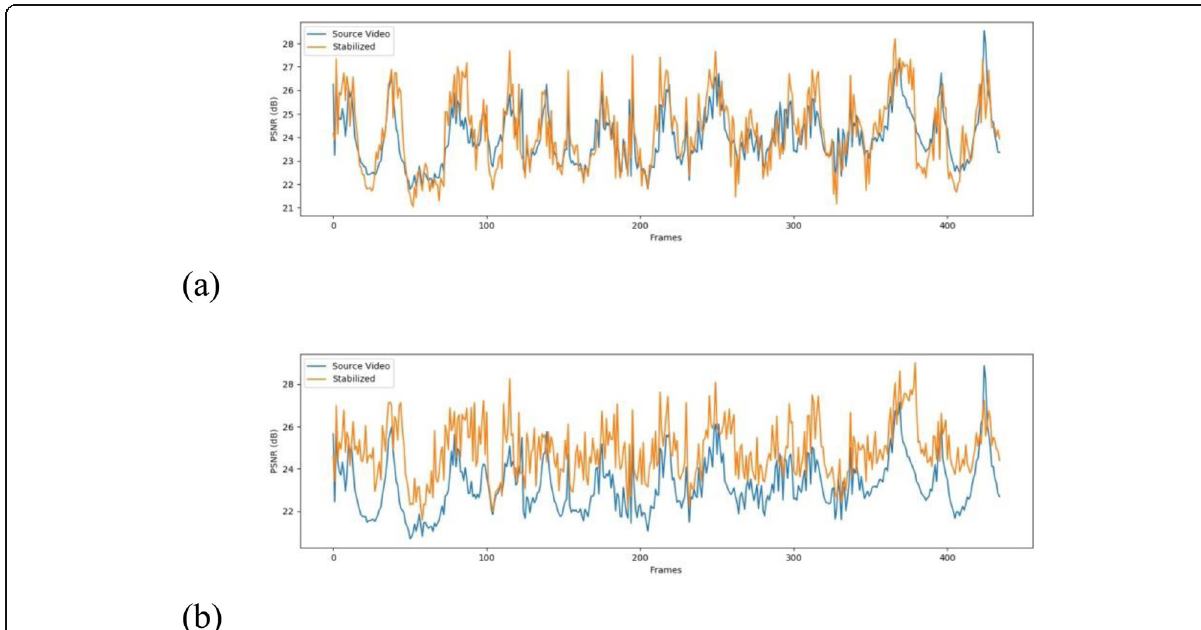
Fig. 7 Graphs of non-cropped and cropped PSNR values from a test video. a : PSNR graph for the source and stabilized video; b : PSNR graph for source and stabilized video with cropped frames